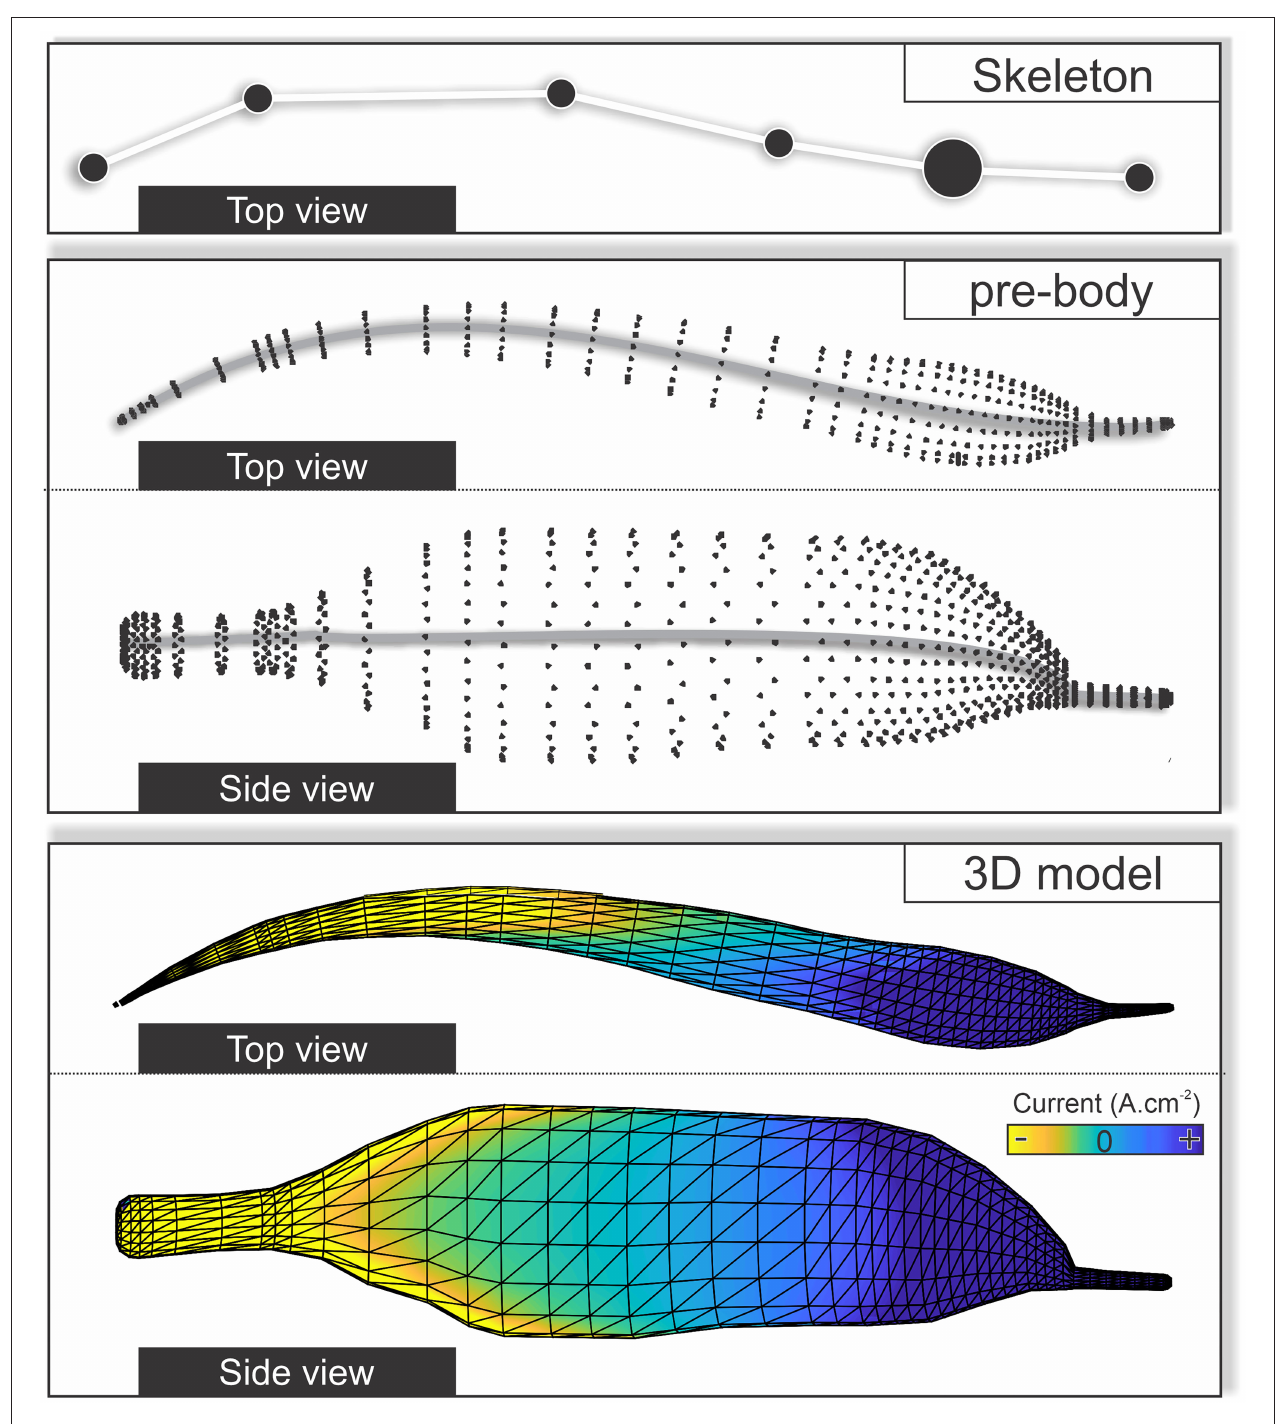
FIGURE 5 | The transition from the fish skeleton estimated by SLEAP to a three-dimensional (3D) model was used to model the electric images (EIs). The skeleton obtained from the tracking procedure is shown in the upper panel and is fitted by a third-order polynomial. A set of pre-defined ellipses that form the body of the 3D fish are then distributed along the polynomial (middle). Note that the ellipses can be scaled in size and distance to match the true size of the fish. The points of the ellipses represent the nodes that are connected to form a total of 1,666 triangles for which we then calculated the EIs using a well-established boundary element method (BEM)